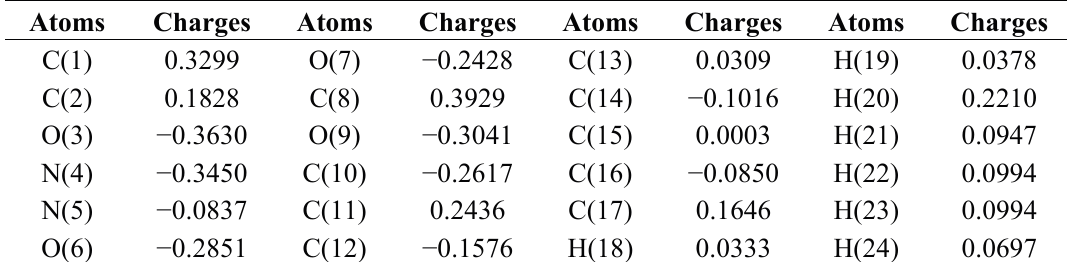
Table 3. Charges (Mulliken Charges) for the